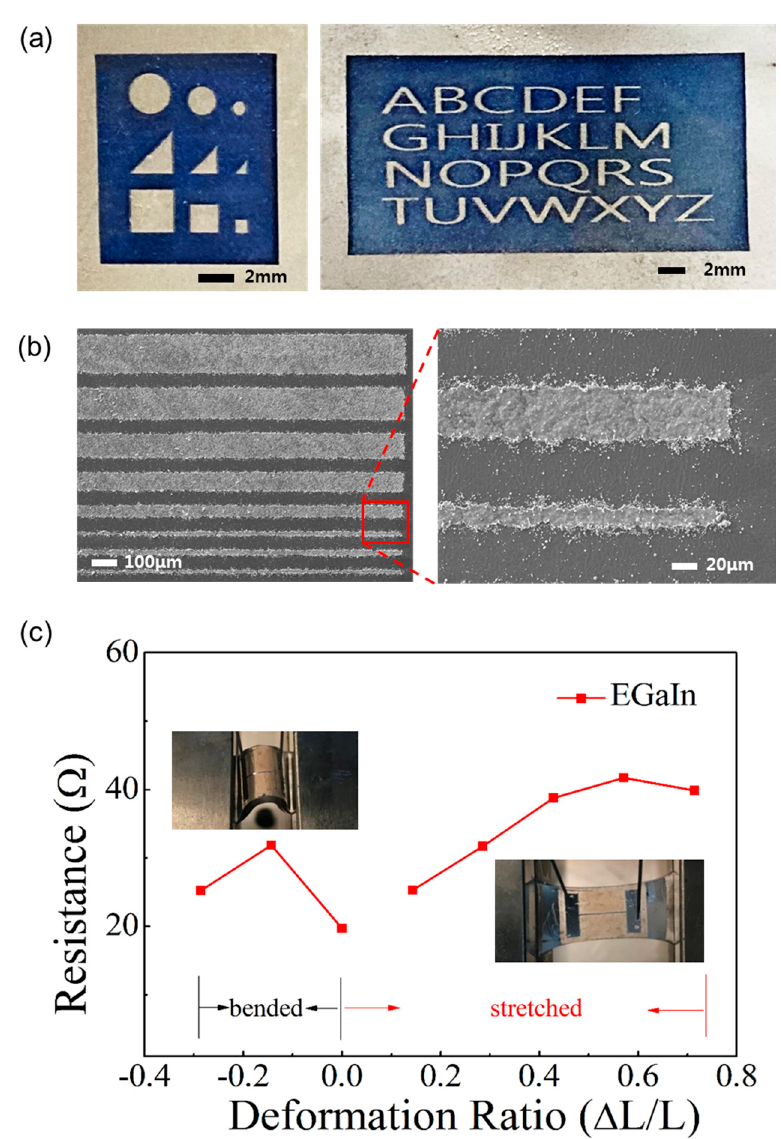
Figure 3. ( a ) Images of a conductive EGaIn film patterned by a fiber laser marker; ( b ) SEM images of conductive EGaIn film patterned by a fiber laser marker, showing a maximum resolution of the pattern of approximately 20 μ m; ( c ) Resistance of the EGaln electrode under bending and stretching.